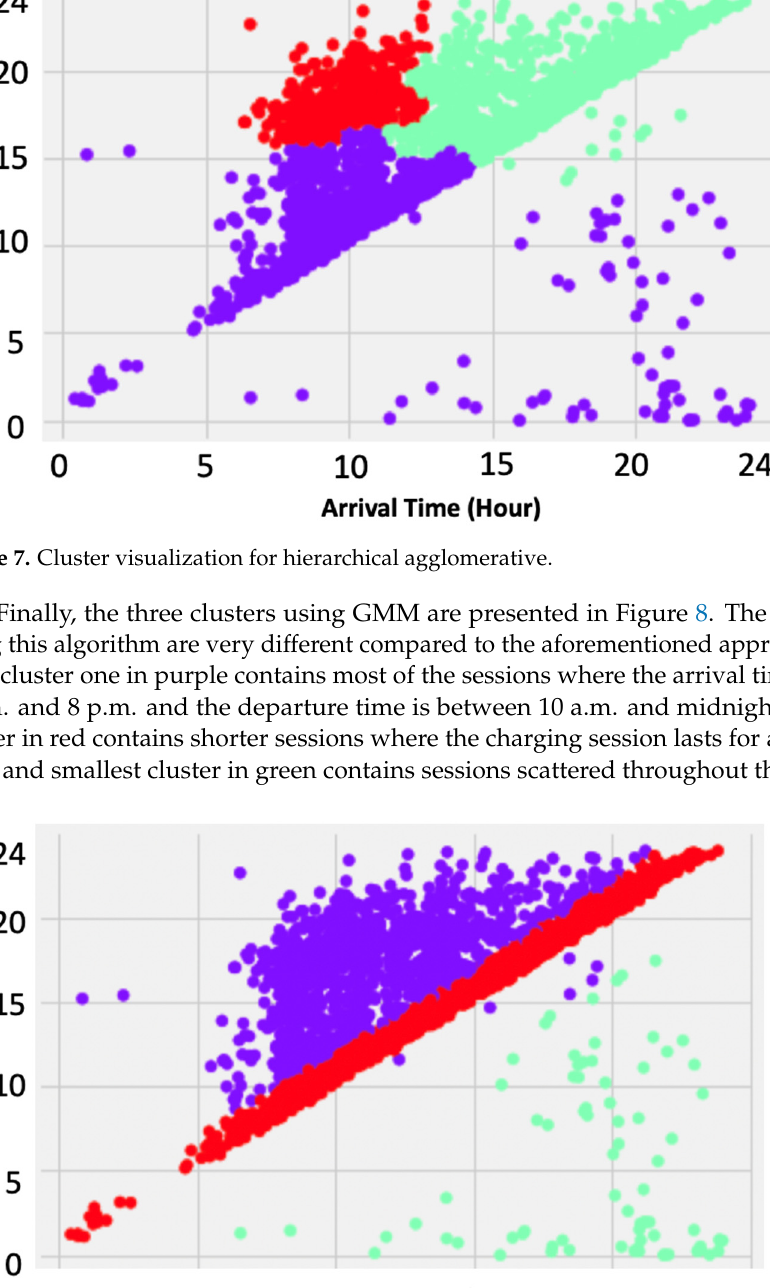
Figure 8. Cluster visualization for GMM.